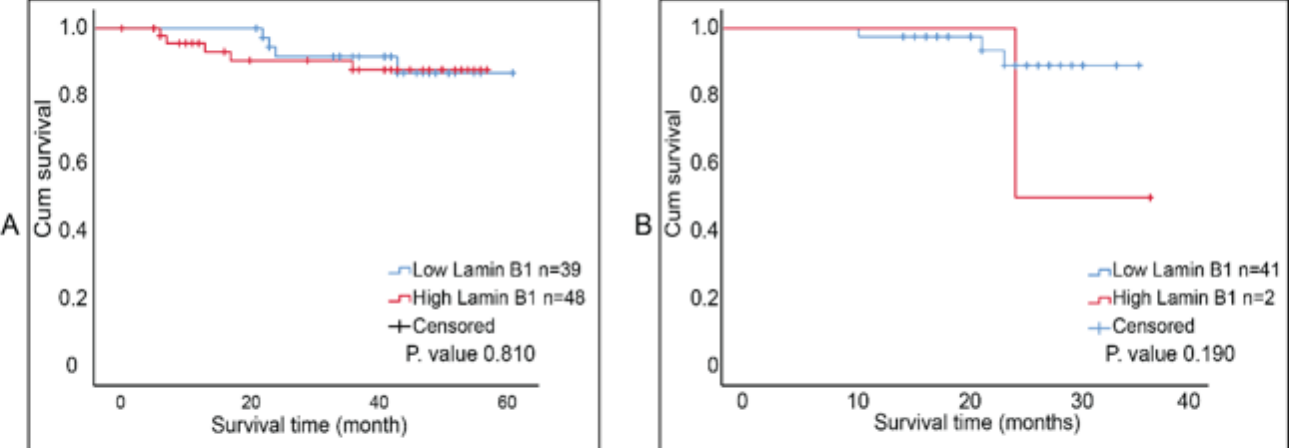
Figure 5. Kaplan Meier survival curves for lamin B1 protein expression in breast cancer samples.